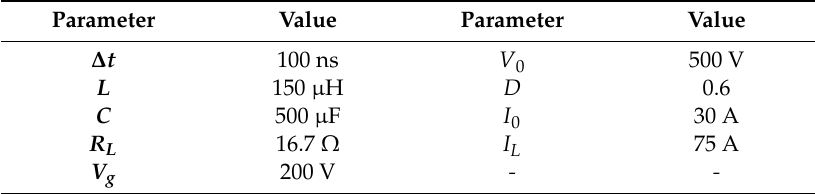
Table 1. Parameters used in the Boost converter.